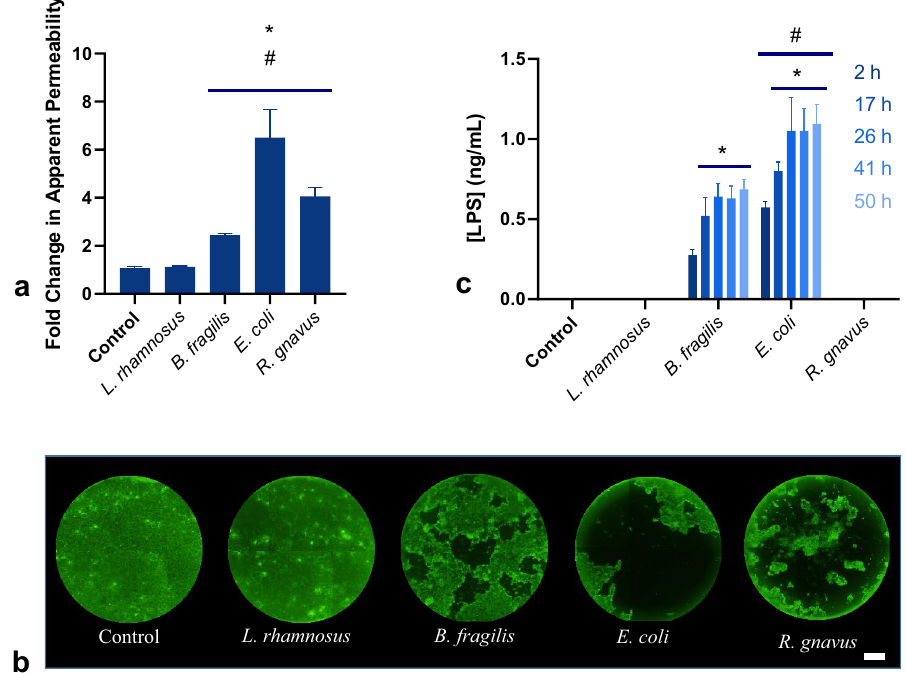
Figure 1. Co-culture of in vitro intestinal mucosa with individual bacterial species results in severe monolayer damage for all co-cultures excluding those co-cultured with L. rhamnosus . ( a ) Fold change in apparent permeability of monolayers after 50 h of co-culture [n = 10 samples from 5 independent experiments, * = Significant difference compared to control ( B. fragilis p = 0.02, E. coli, R. gnavus p < 0.0001), # = Significant difference compared to L. rhamnosus co-cultures ( B. fragilis p = 0.04, E. coli, R. gnavus p < 0.0001)]. ( b ) Representative Calcein AM stained monolayers after 50 h co-culture (Scale bar = 1 mm). ( c ) Lipopolysaccharide concentration measured in apical media [n = 10 samples from 5 independent experiments, * = Significant difference compared to 2 hour timepoint within the same group ( B. fragilis p = 0.03 to < 0.0001, E. coli p = 0.01 to < 0.0001), # = Significant difference compared to B. fragilis at the same timepoint (p = 0.03 to <